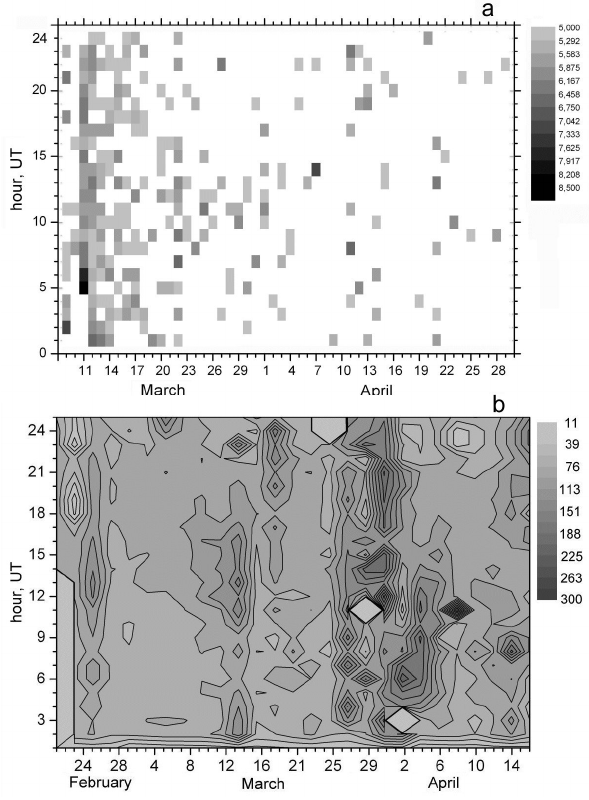
Fig. 3. The picture of seismic events with M > 5 occurring near Japan in the angular sector of atmospheric observation ± 20 ◦ rela- tive to the direction of the “virtual center” from 9 March 2011 to the end of April 2011 (a) and the variations of average AA at all hours of the day for the interval from 21 February to 16 April 2011 (b) .